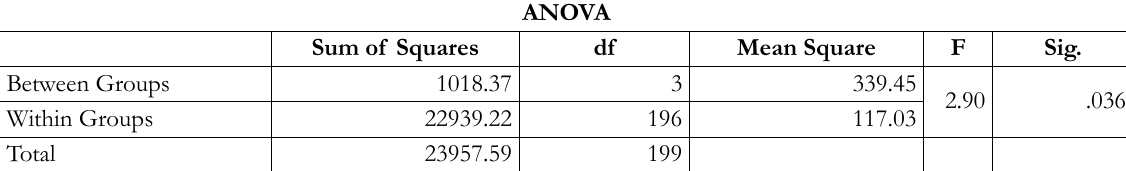
Table 5. ANOVA test